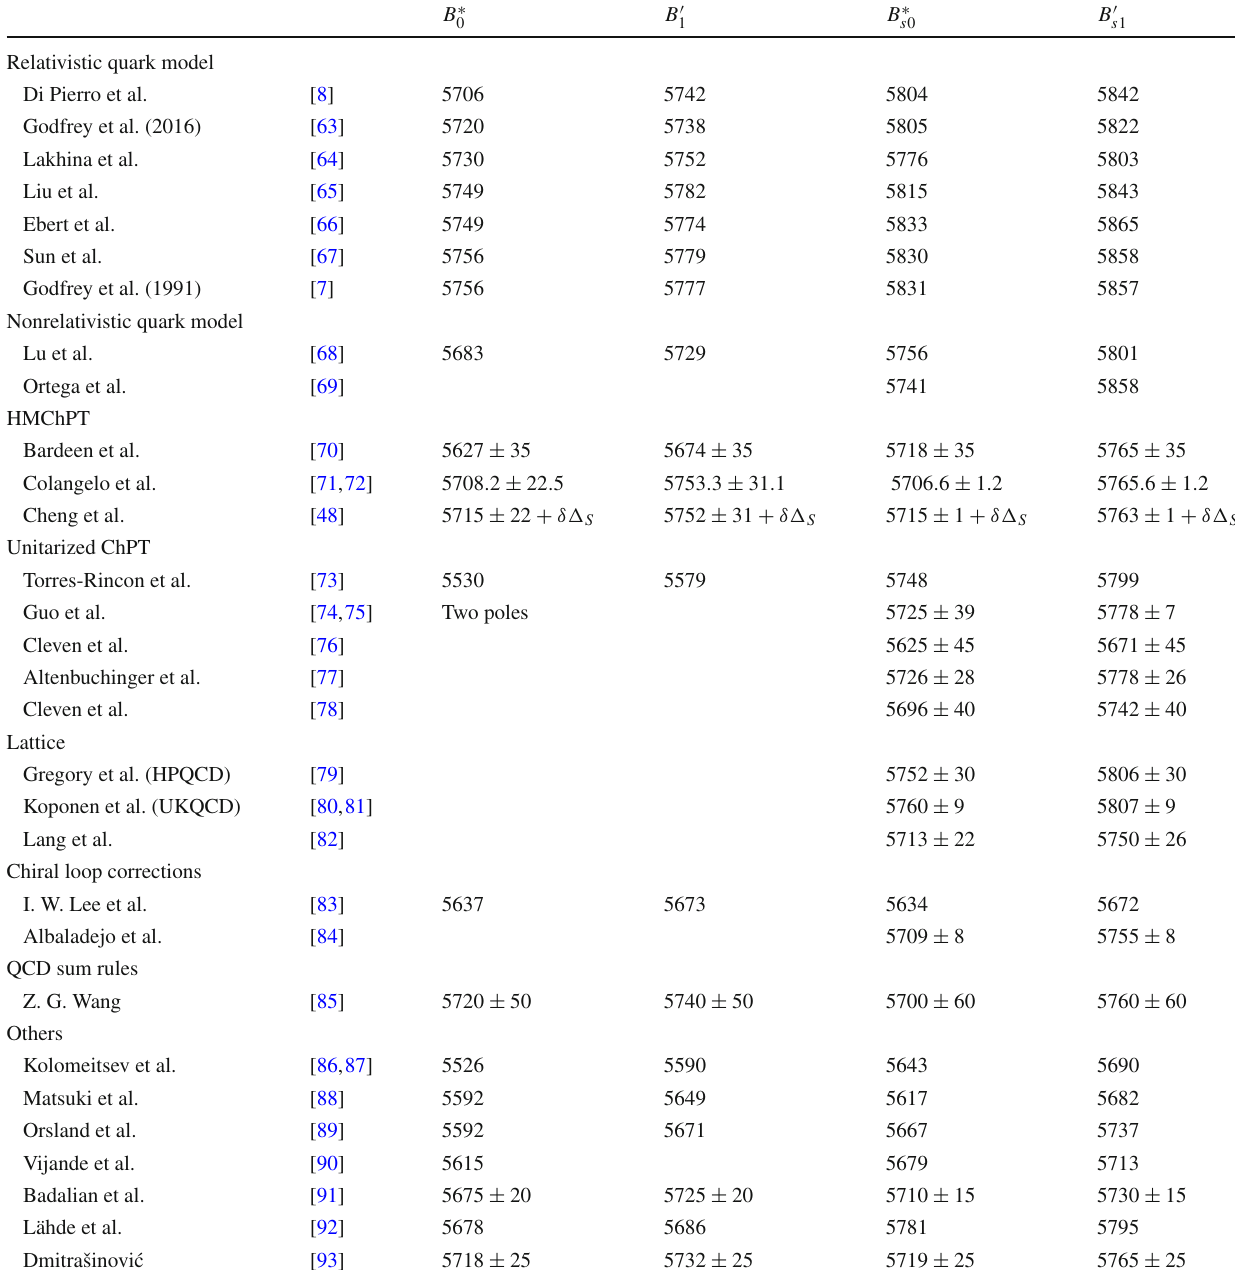
and B (cid:3) ( mesons in the s ) 0 s ) 1